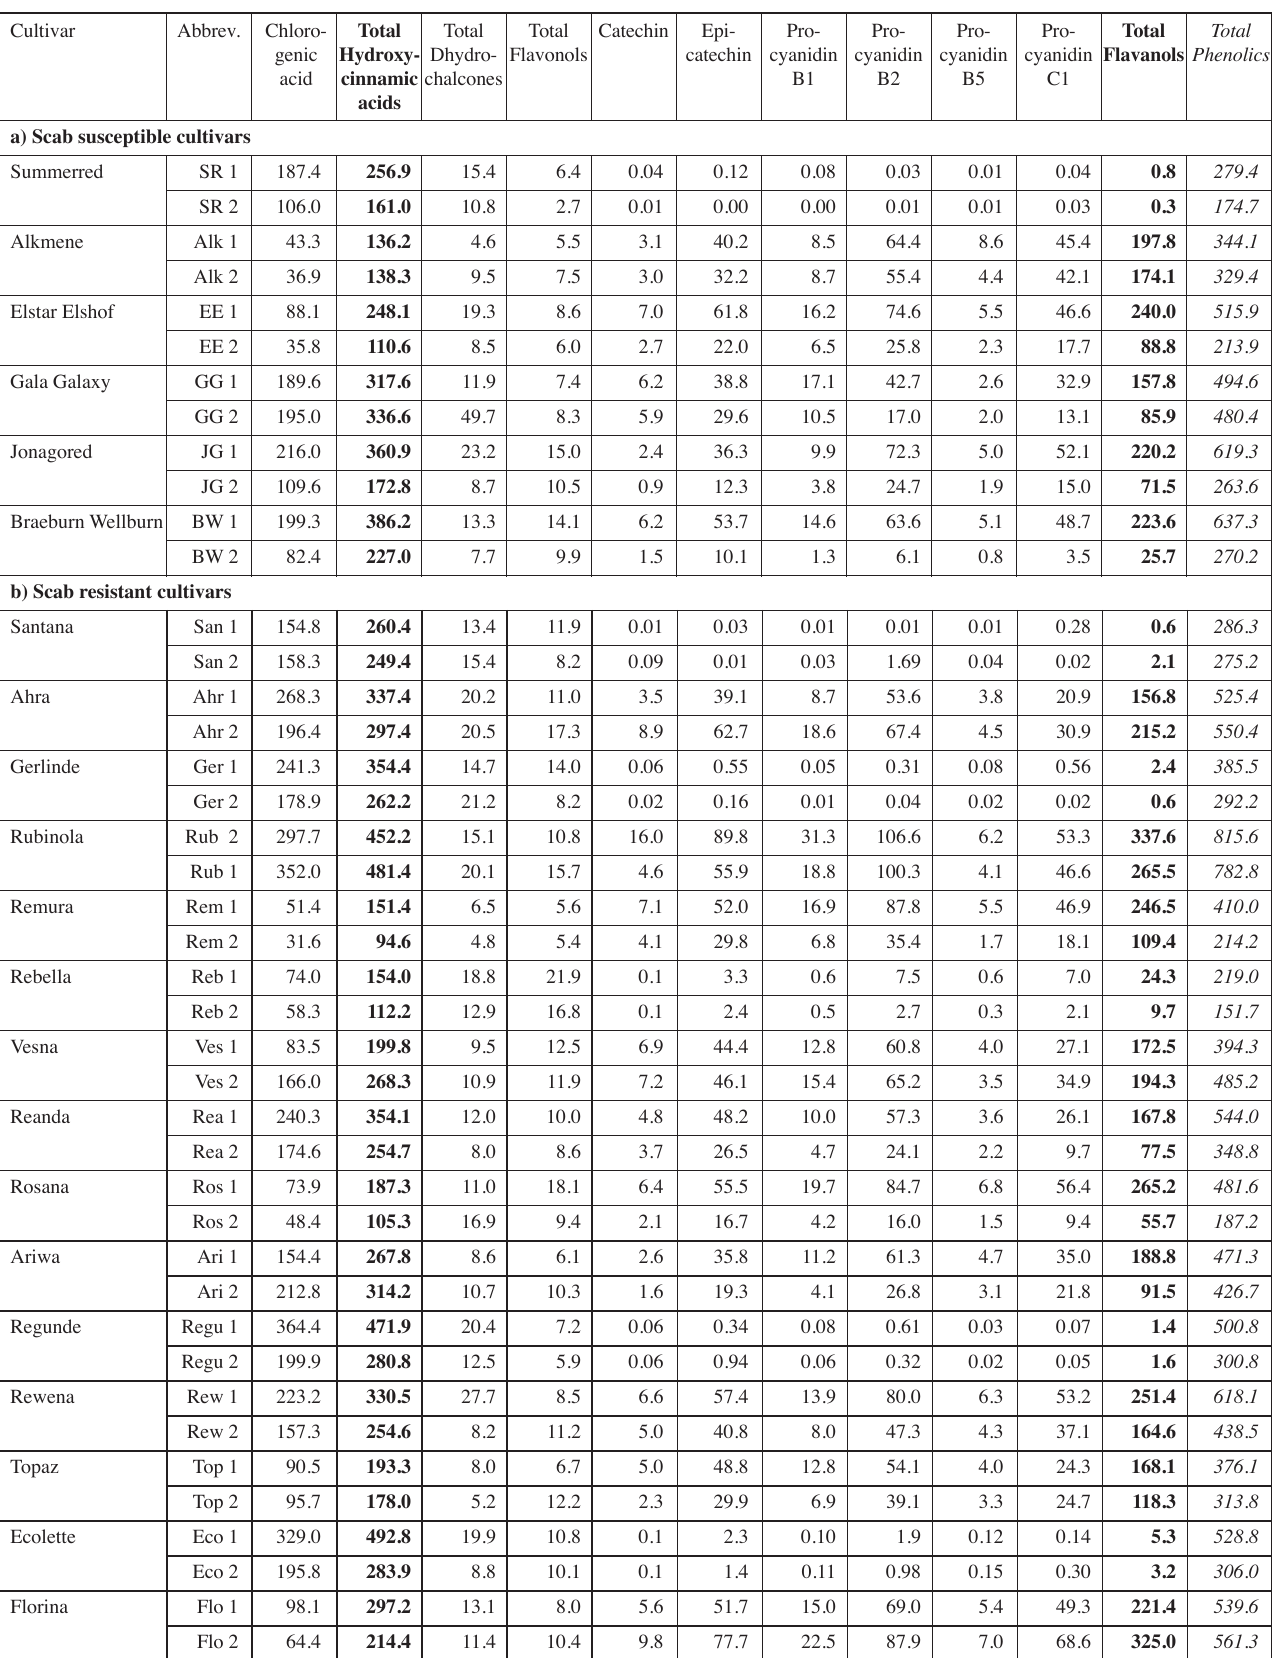
Tab. 2: Phenol content (mg/L) of apple juices (apples harvested in 2001/2002) estimated by HPLC analysis